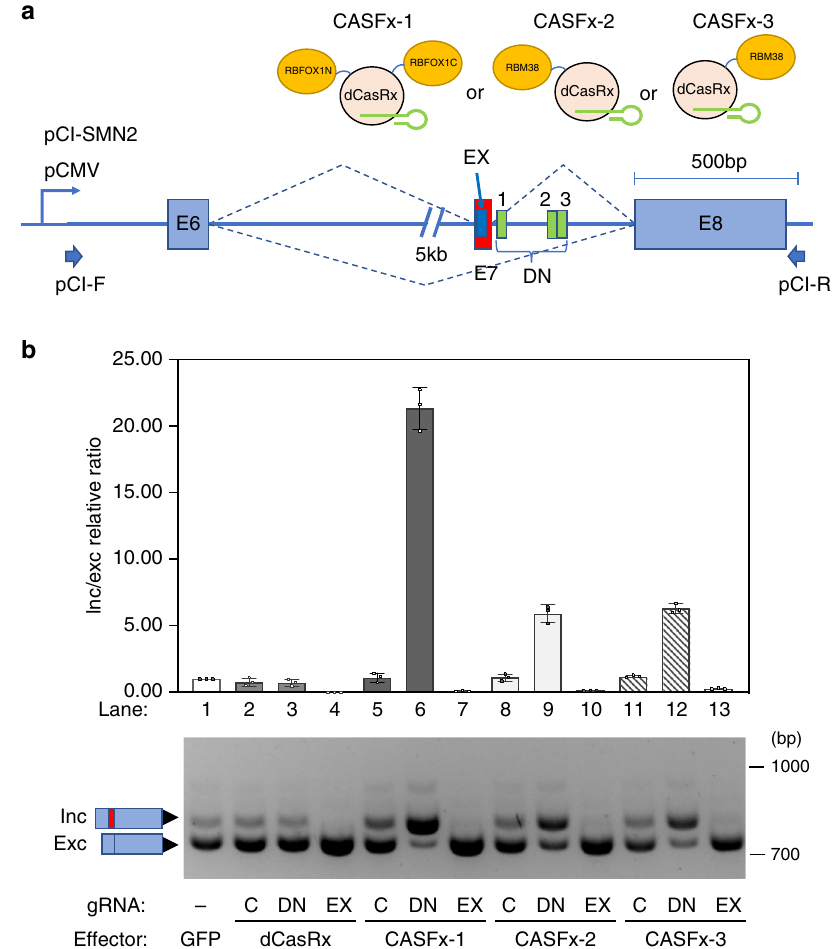
Fig. 2 Activation and repression of exon by differential positioning of CASFx. a Schematic of the CRISPR arti fi cial splicing factors, CASFx-1 (RBFOX1N- dCasRx-C), CASFx-2 (RBM38-dCasRx), CASFx-3 (dCasRx-RBM38) and SMN2 minigene, as well as a set of three target sites downstream of E7 (DN: gRNA-1 through 3) and one target site target within E7 (EX). b Upper panel shows the inclusion/exclusion (inc/exc) ratio fold-change assayed by qRT-PCR on SMN2 minigene transcripts in cells co-transfected with dCasRx, CASFx, and the indicated gRNAs, with respect to the GFP control (set to 1). Data are represented as mean ± SD ( n = 3). Lower panel shows a gel image of semi-quantitative splicing RT-PCR of the corresponding samples. “ C ” indicates a control gRNA without matching SMN2 minigene sequence; “ DN ” indicates a pool of three gRNAs (SMN2-gRNA-1 through 3) targeting downstream of E7; “ EX ” indicates a gRNA targeting within E7. Uncropped gel images and qRT-PCR values are included in the Source Data fi